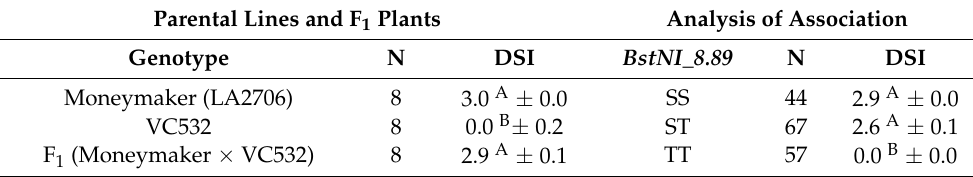
Table 6. Analysis of association between the BstNI_8.89 marker and ToBRFV disease severity index (DSI) in F 2 plants originating from an initial cross between the susceptible genotype LA2706 and the tolerant VC532